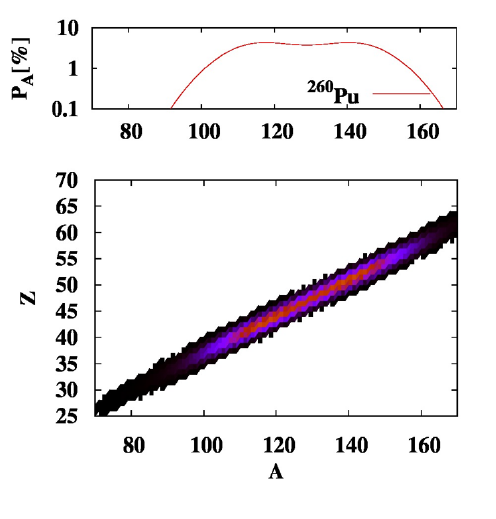
Figure 3. Abundance pattern of a single r-process nucleosynthesis with the electron fraction Y e = 0.05. Red, green, blue lines are results with present model, Kodama-Takahashi model, and symmetric fission model, respectively. Filled grey circles with error bars are the r-elements in the solar